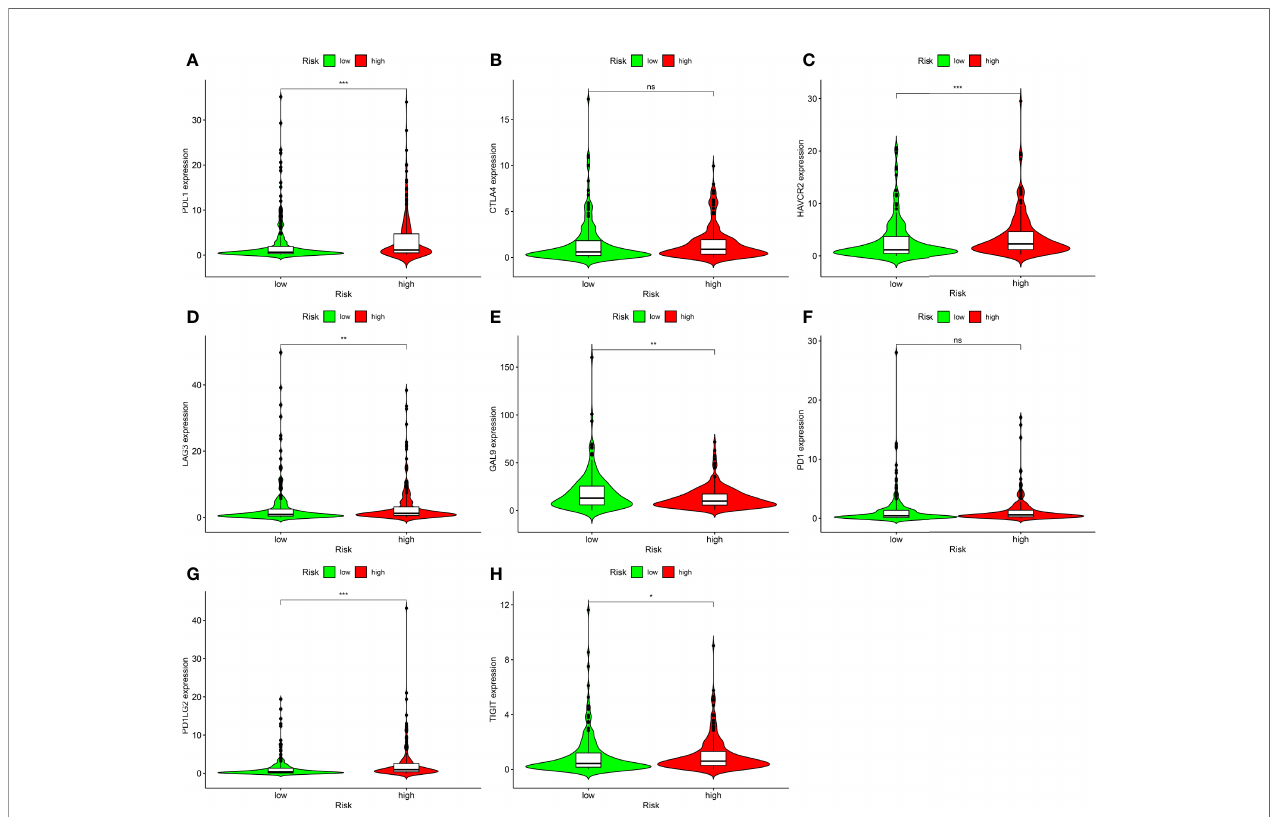
FIGURE 8 | Correlation analysis between risk models and immune checkpoints of BLCA. (A) PDL1. (B) CTLA4. (C) HAVCR2. (D) LAG3. (E) GAL9. (F) PD1. (G) PDCD1LG2. (H) TIGIT in high- and low-risk BLCA patients. Ns, not signi fi cant; *p < 0.05; **p < 0.01; ***p < 0.001.